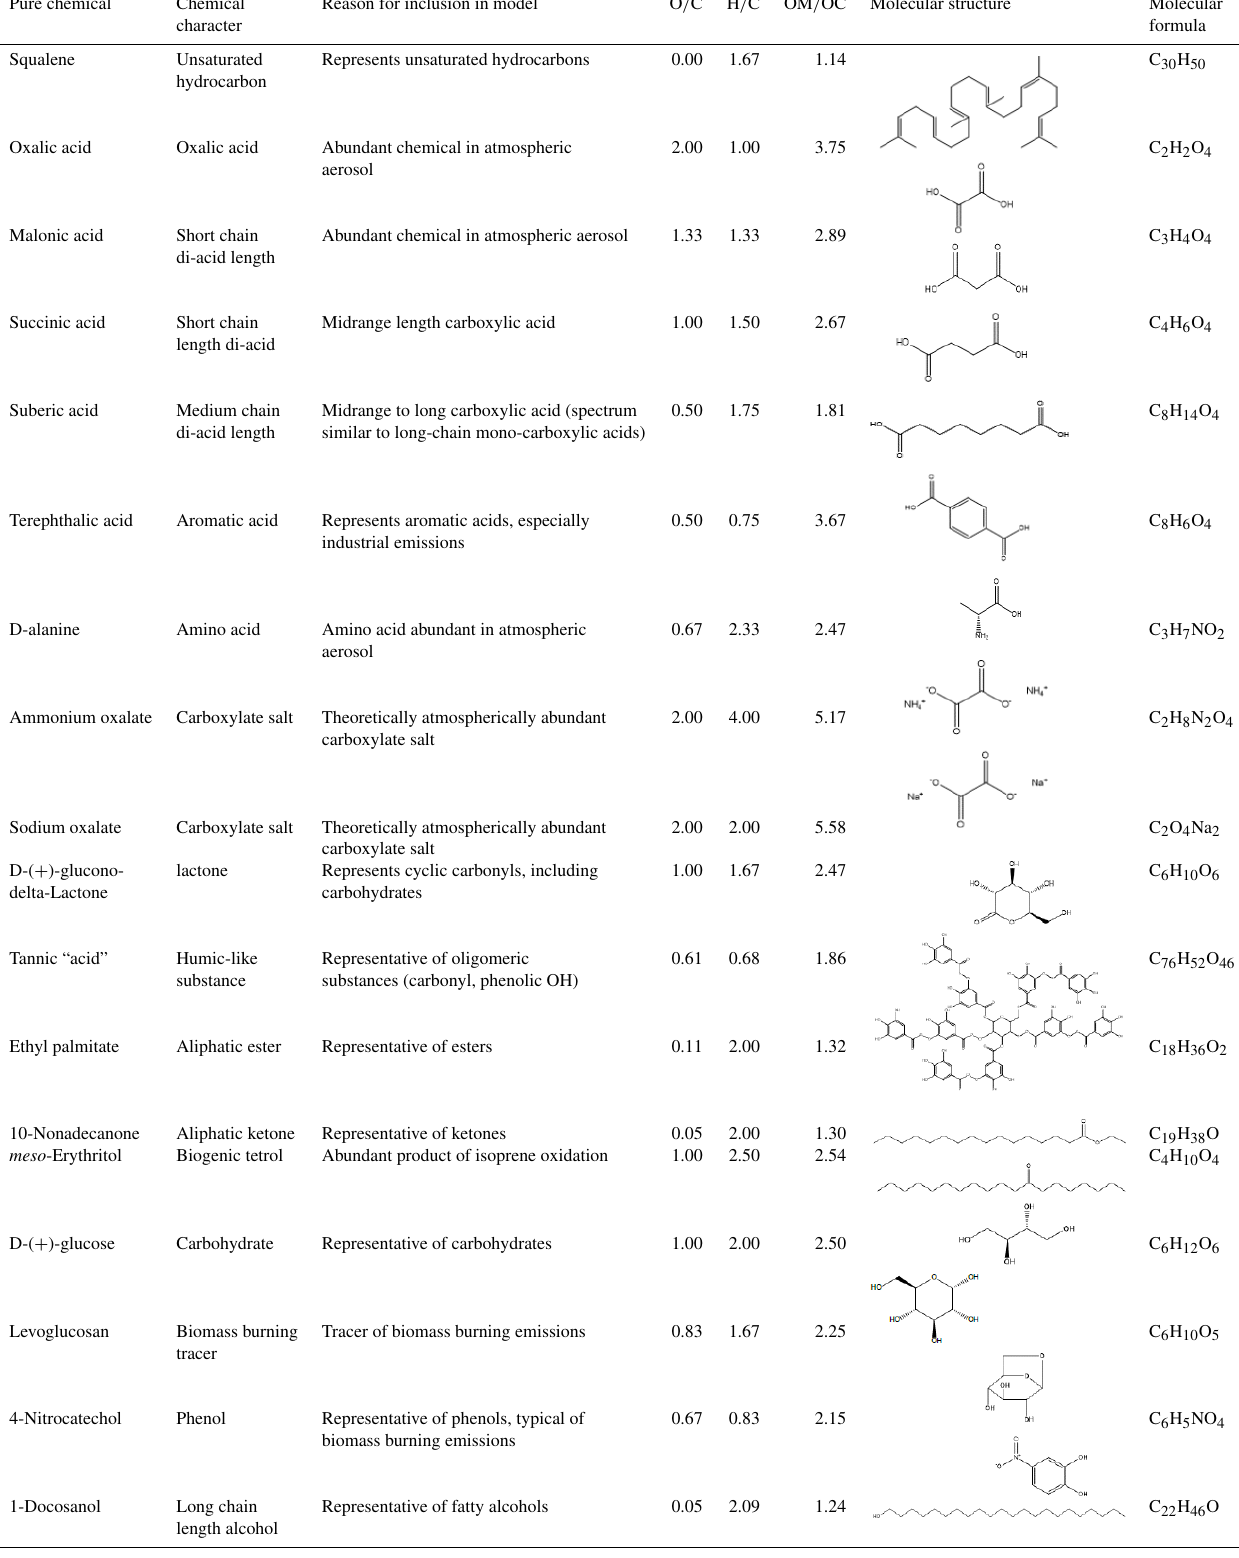
Table 1. Pure chemicals collected as laboratory standards and used in the calibration of FT-IR spectra for functional group concentrations. Pure chemical Chemical Reason for inclusion in model O / C H / C OM / OC Molecular structure Molecular character formula Squalene